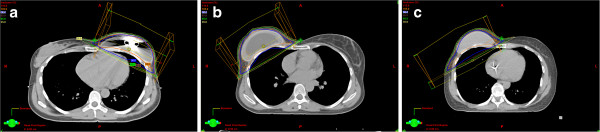
Radiotherapy plan with: A. Temporary expander with magnet (
type I
), B. Expandable implant (
type II)
, C. Permanent implant (
type III
).